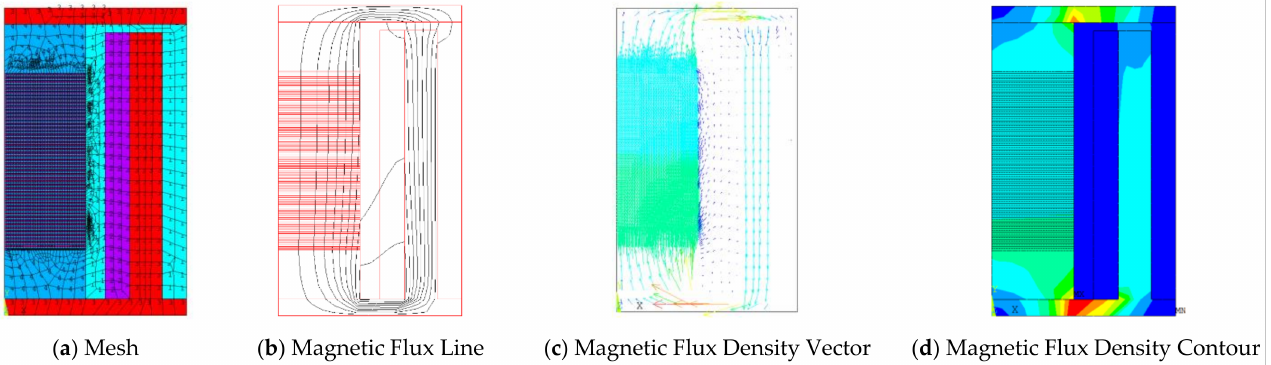
Figure 12. Finite Element Modeling of